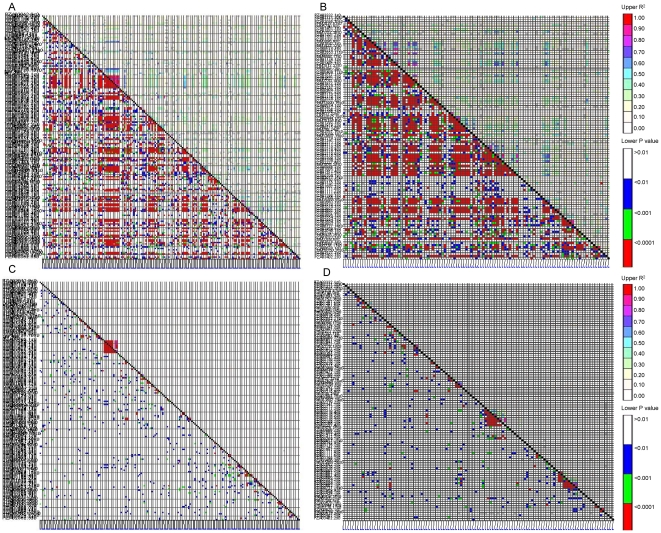
Linkage disequilibrium (LD) patterns on chromosomes 4 and 10 in temperate maize germplasm set (A and B) and tropical maize germplasm set (C and D) genotyped with 170 and 111 SNPs, respectively.The squared correlation coefficients (R
2) for each pair of markers are presented in the upper triangle and their corresponding tests in the lower triangle: white p>0.01, blue 0.01>p>0.001, green 0.001>p>0.0001 and red p<0.0001. The SNPs on each chromosome were aligned up from the left to right long the x-axis and their names and other information can be found from Table S1.